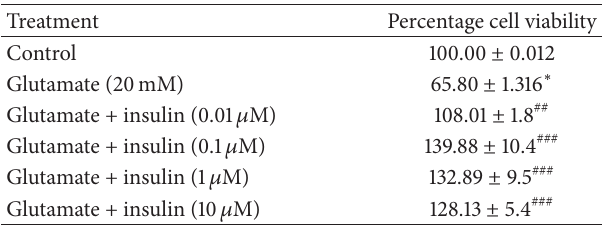
Table 4: Percentage of apoptotic cells in differentiated SH-SY5Y cells after